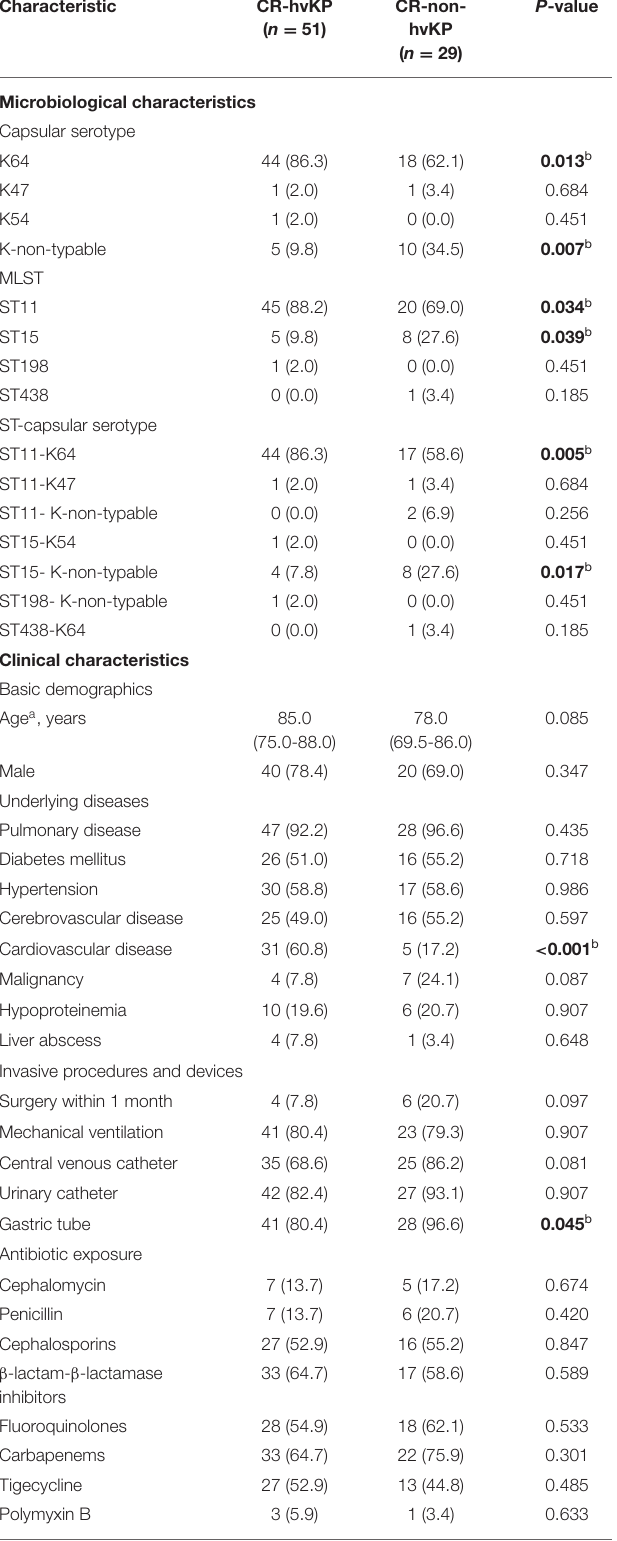
TABLE 1 | Microbiological and clinical characteristics of CR-hvKP strains.